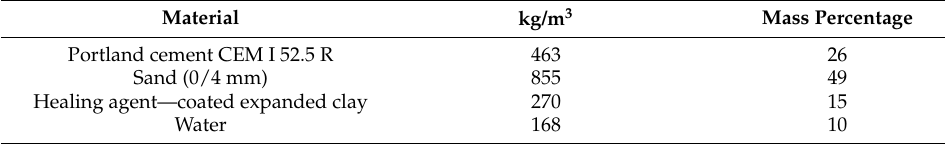
Figure 2. Laboratory tests on BSHC: ( A ) specimens of test Series 1; ( B ) specimens of test Series 2; ( C ) crack measurement scheme; ( D ) healing conditions. Table 1. Composition of